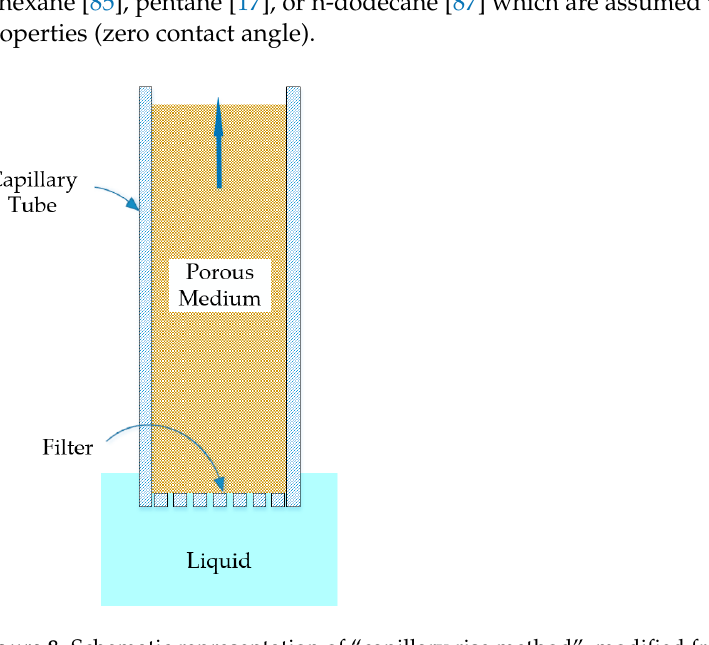
Figure 8. Schematic representation of “capillary rise method”, modified from [88]. Contact angle can be calculated by either measuring the rate of rise of imbibing solution or determining the pressure that should be applied to prevent the wetting fluid from entering the capillary tube [88]. This backpressure is equal to capillary pressure calculated by using the equation of capillarity (Equation (18)).